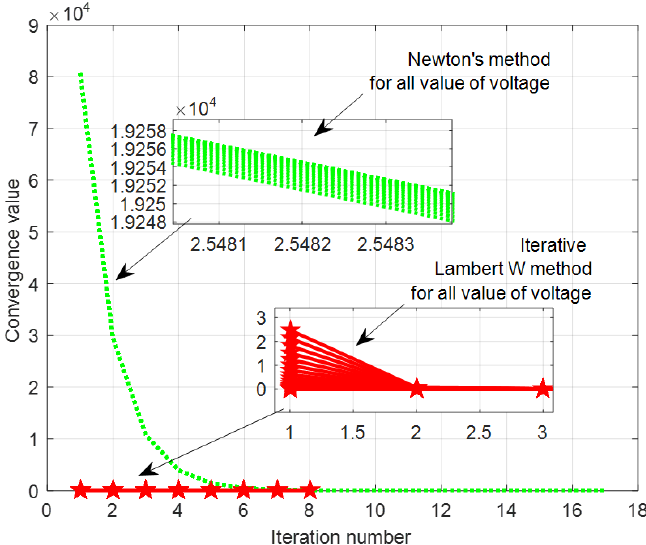
Figure 14. Convergence curves for NM and the ILWF for all values of the measured voltage of the solar Photowatt-PWP201 module.